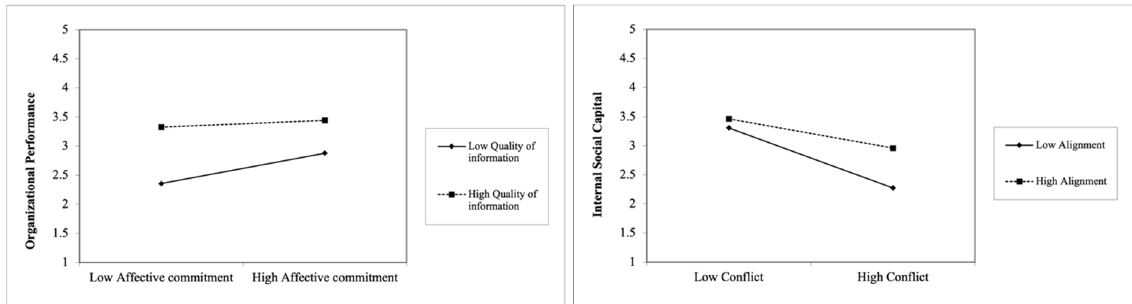
Figure 3. Moderation